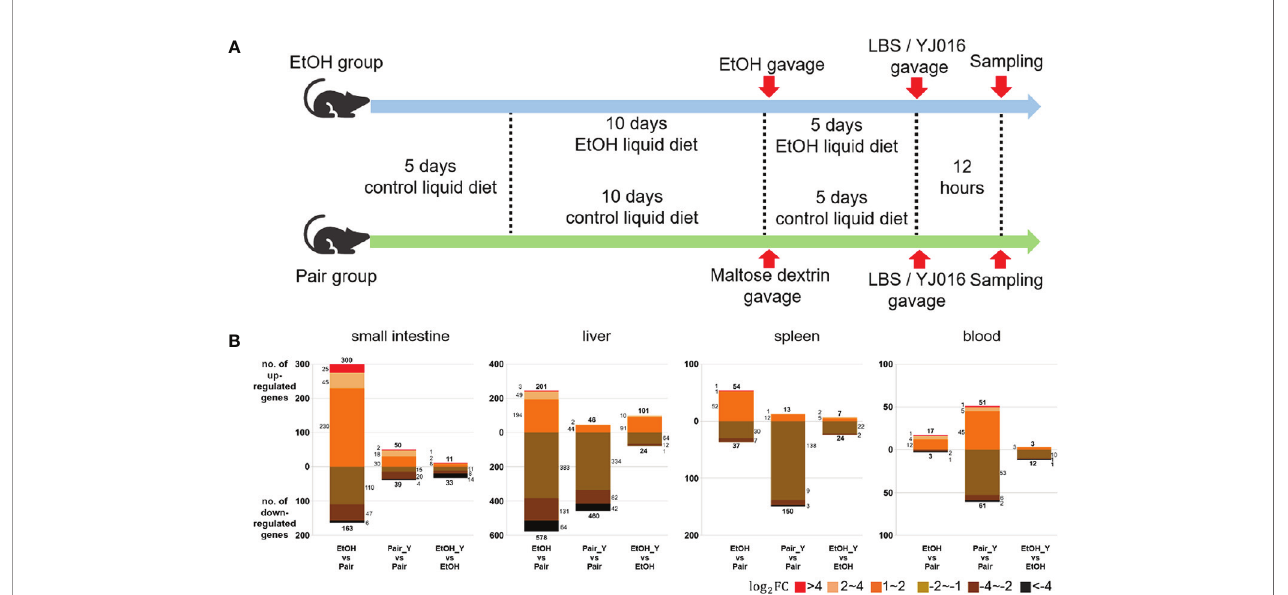
FIGURE 2 | Experimental design and transcriptome response in mice after YJ016 infection. (A) On the fi fth day after gavage (the 15th day of alcohol feeding), mice were given 10 8 CFU V. vulni fi cus YJ016 culture or LBS as a control by gavage (n = 15 for the Pair and EtOH groups). After LBS or YJ016 gavage, fi ve mice in each subgroup were used for RNA sequencing; The others were used for further analysis. (B) Transcriptome response of mice in the EtOH and Pair groups after infection with